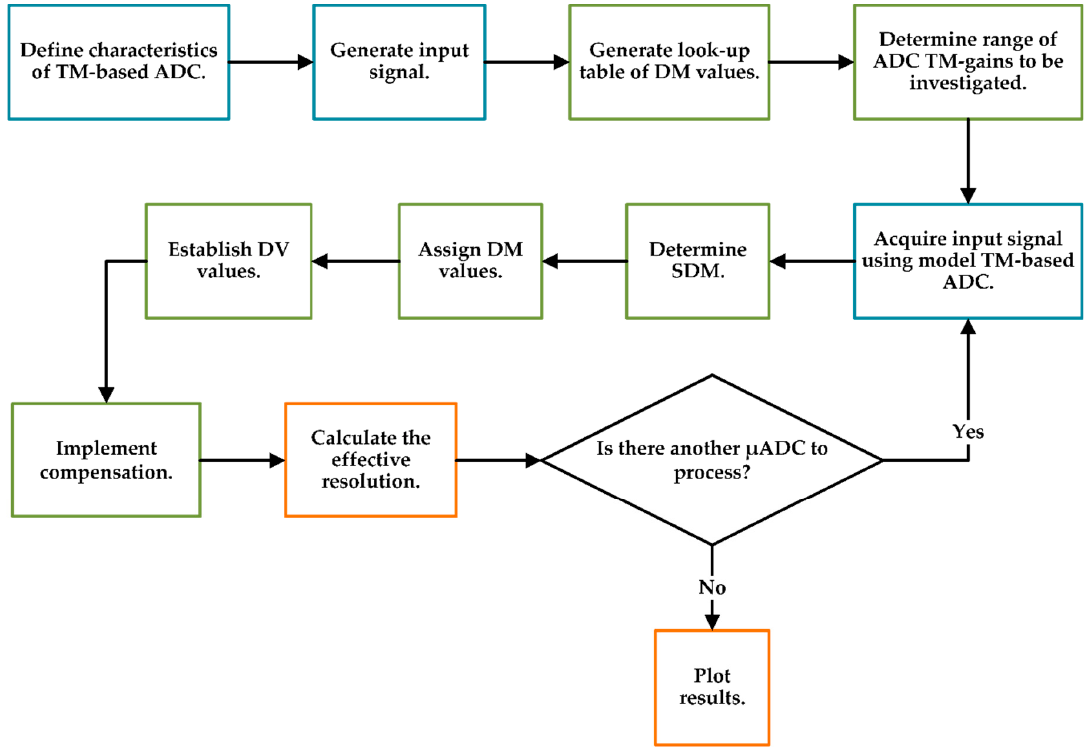
Figure 13. Flow diagram of MATLAB script developed to perform the sensitivity analysis.